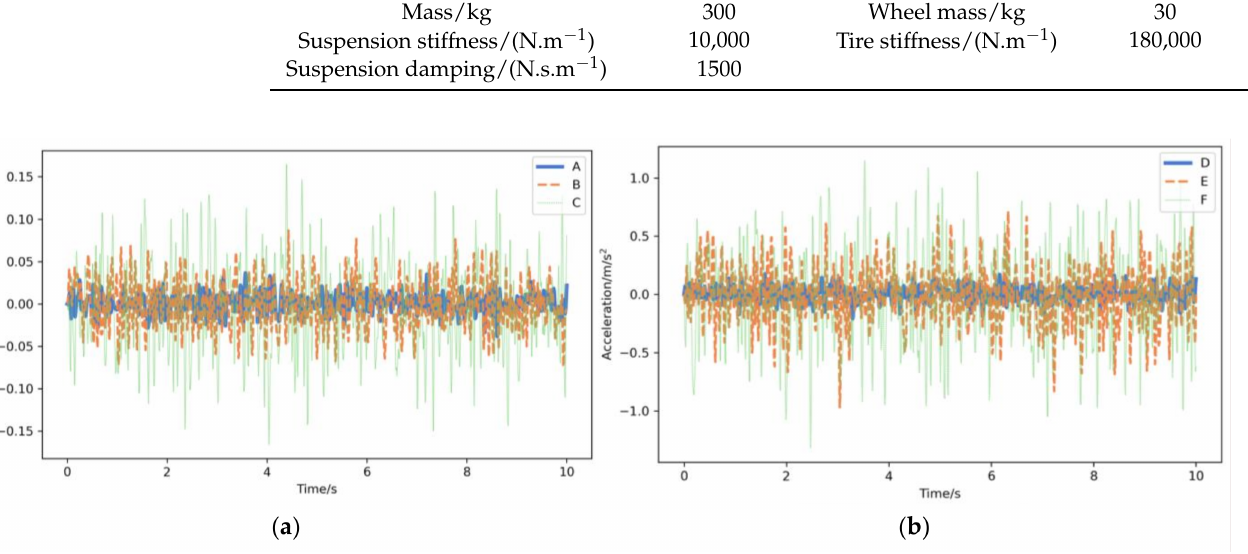
Figure 6. Acceleration response for different pavement roughness grades: ( a ) grades A–C; ( b ) grades